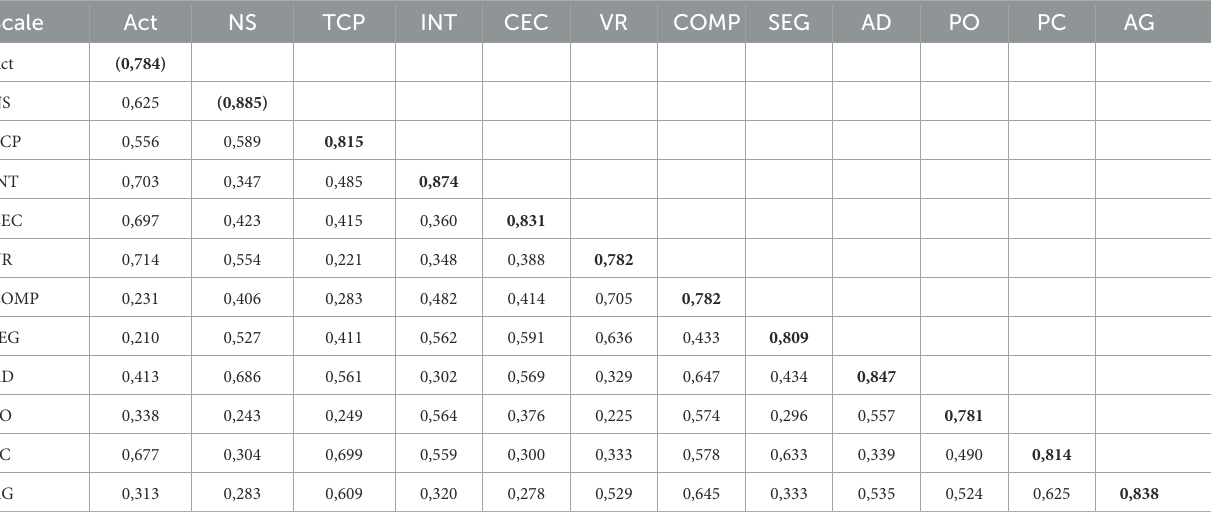
TABLE 3 Discriminant validity (Fornell-Larcker